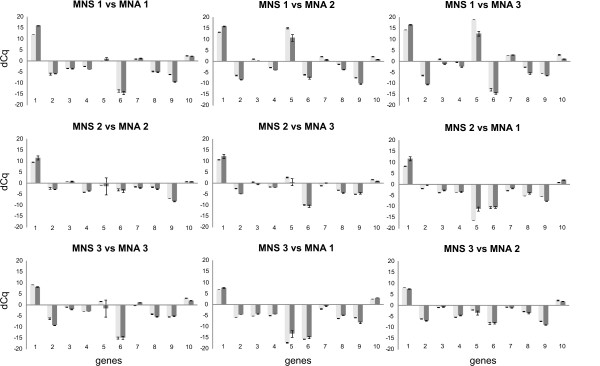
Preservation of differential expression after pre-amplification. Differential expression (expressed as difference in Cq or delta-Cq (dCq)) of 10 genes in three MYCN single copy (MNS) neuroblastoma cell lines (1: GI-ME-N; 2: SK-N-AS; 3: SK-N-SH) and three MYCN amplified (MNA) neuroblastoma cell lines (1: IMR-32; 2: N206; 3: NGP) before (light grey bars) and after sample pre-amplification (dark grey bars). The x-axis represents the differentially expressed genes. 1:MYCN; 2:INHBA; 3:RGS4; 4:DKK3; 5:NTRK2; 6:TGFBI; 7:PMP22; 8;PLAT; 9:CMYC; 10:MTHFD2. The dCq between MNS and MNA samples remains almost unchanged after pre-amplification indicating a preservation of differential expression.